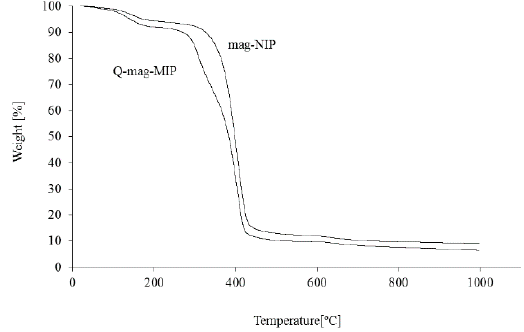
Figure 2. Thermogravimetric curves for Q-mag-MIP and magnetic non-molecular imprinted polymer (mag-NIP).